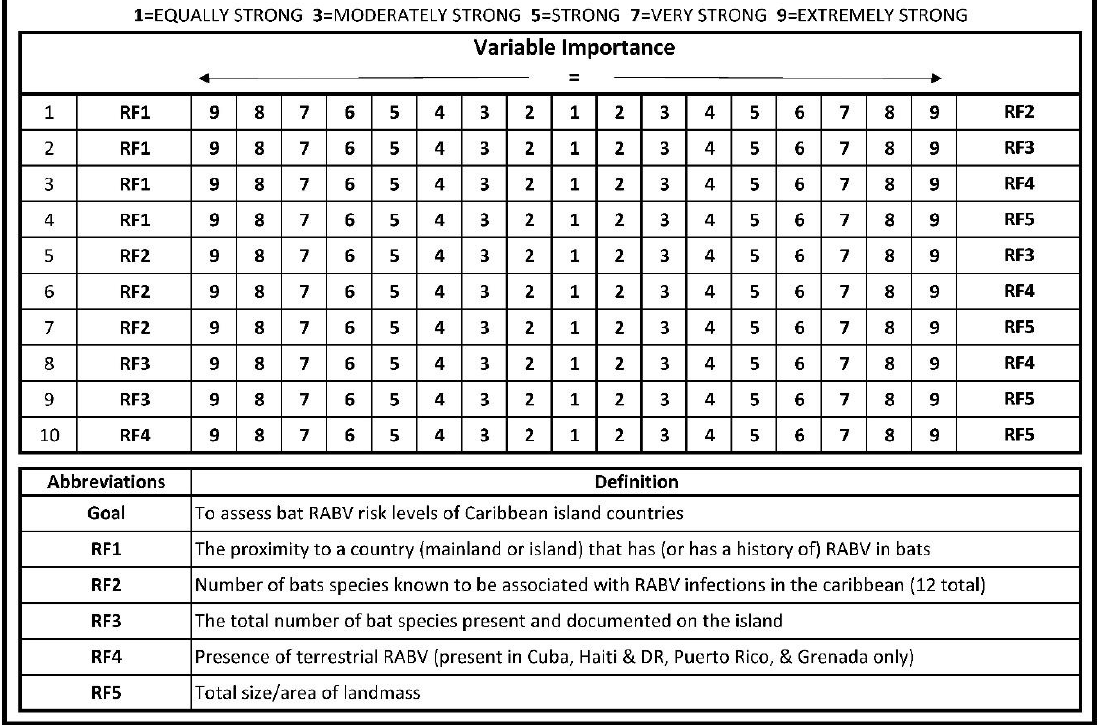
Figure 1. The pairwise comparison survey questionnaire sent out to subject matter experts to assess the risk factors that could potentially contribute to rabies presence in bat populations in the Caribbean